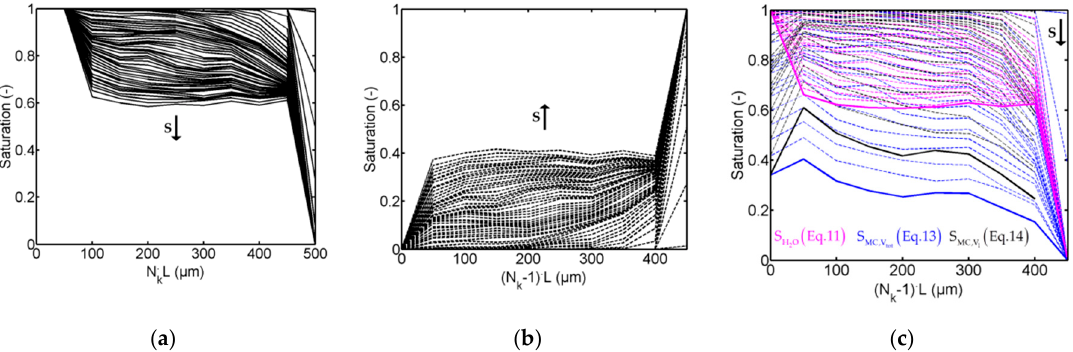
Figure 9. ( a ) Transient liquid saturation profiles of the one PN simulation shown in Figures 7 and 8. ( b ) The according gas saturation profiles. The catalyst side is found on the right (corresponding to the top of PN) and the water supply channel is found on the left (corresponding to the bottom of PN). The saturation profiles are shown for overall liquid saturation S = [1:0.61] (the final saturation is S = 0.6). ( c ) Saturation profiles of the liquid transporting clusters for S = [1:0.62].